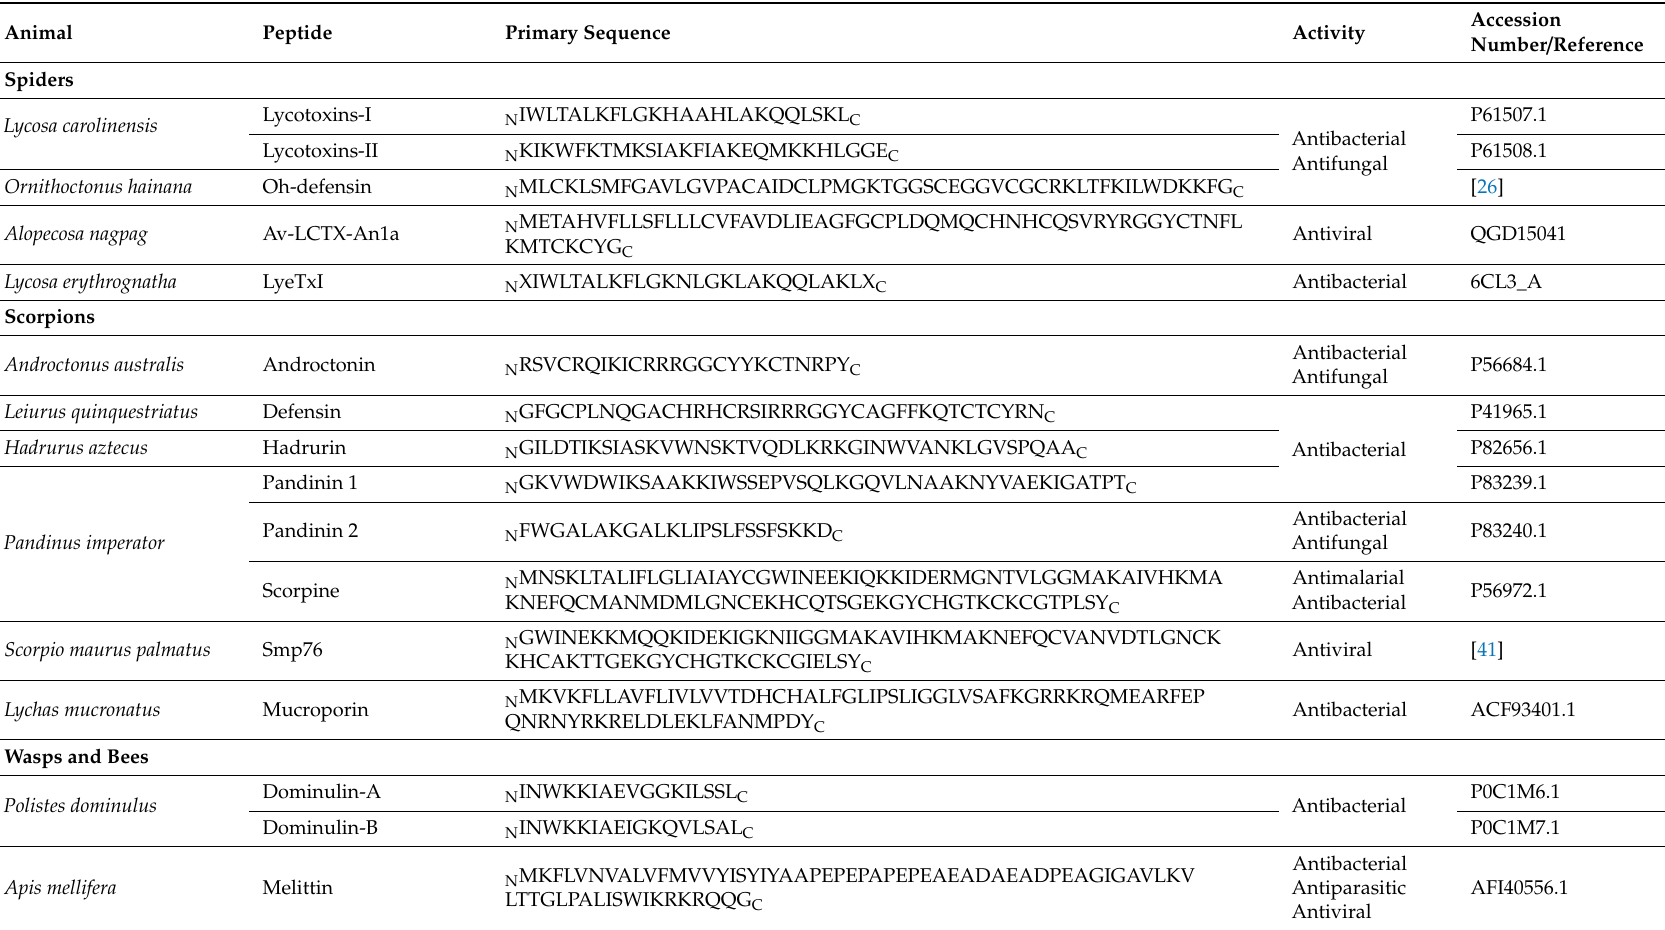
Table 1. Primary sequences of antimicrobial peptides from animal venoms / secretions with their respective antimicrobial activity. The accession number / reference of each peptide is